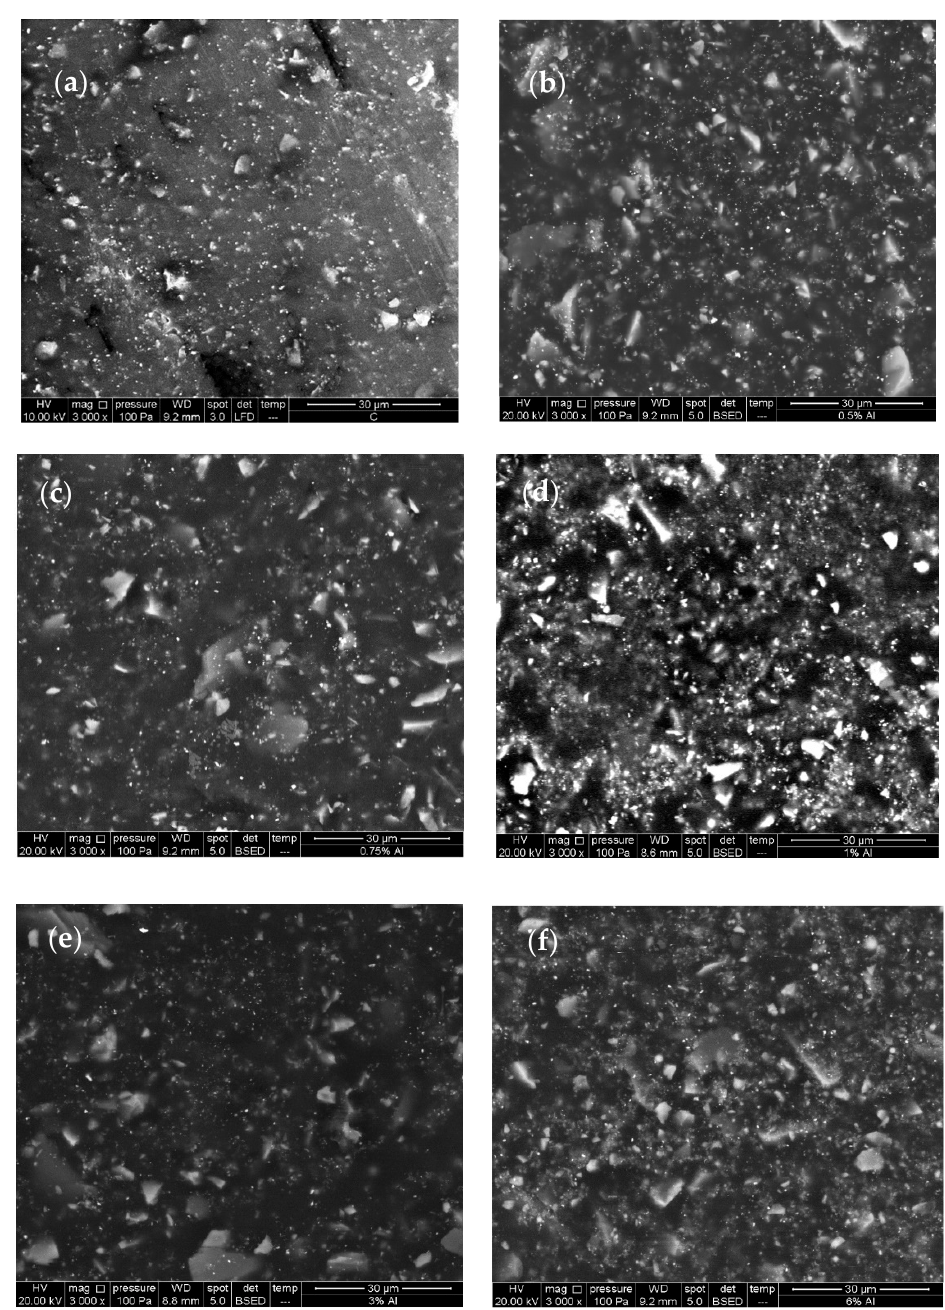
Figure 5. SEM micrographs obtained for the surface of ( a ) blank epoxy and epoxy coating with ( b ) 0.50% Al nanoparticles, ( c ) 0.75% Al nanoparticles, ( d ) 1.0% Al nanoparticles, ( e ) 3.0% Al nanopar- ticles, and ( f ) 6.0% Al nanoparticles.